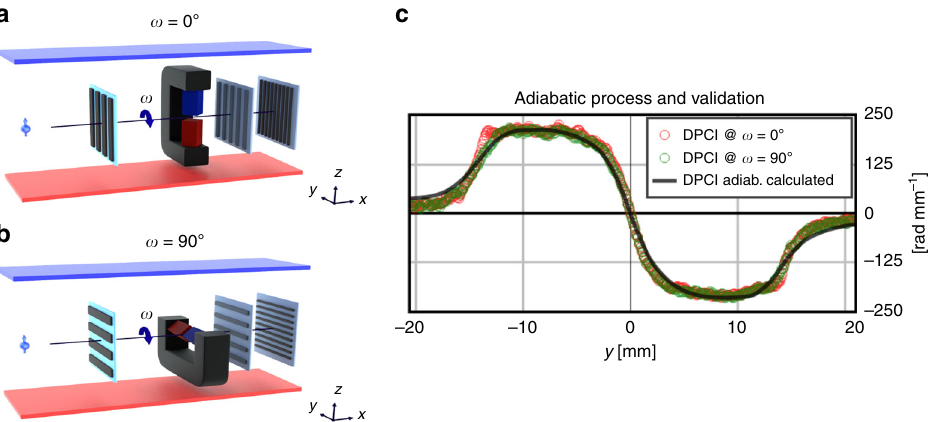
Fig. 5 Adiabatic spin regime. Clari fi cation of the adiabatic spin regime assumption for the two different con fi gurations. a Sketch of the ω = 0° con fi guration with the grating lines and the homogeneous, well-de fi ned, square-shaped and uniaxial magnetic fi eld oriented along the initial neutron spin state and guide fi eld. b Sketch of the ω = 90° con fi guration of the grating lines and the uniaxial magnetic fi eld-oriented perpendicular to the initial neutron spin state and guide fi eld. c Comparison and validation of the differential phase contrast image (DPCI) signals of the ω = 0°, ω = 90° con fi gurations and the calculated one in the adiabatic spin regime